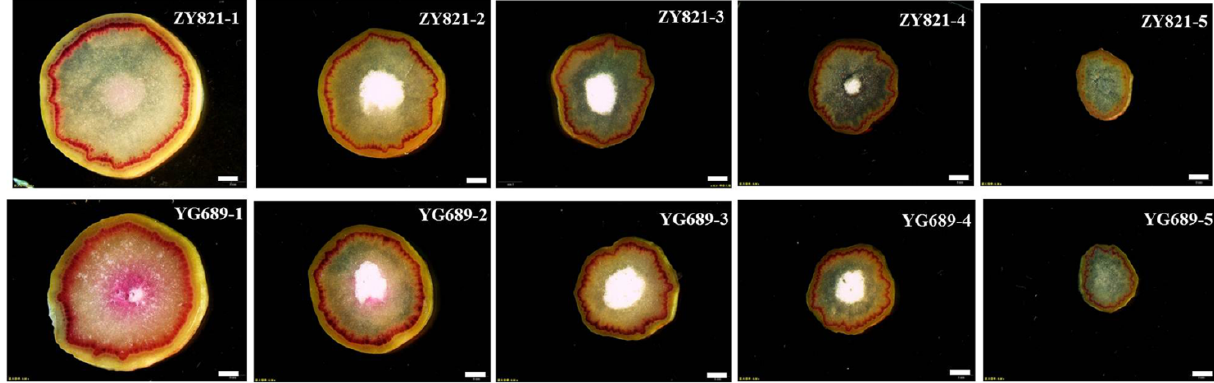
Figure 2. Transverse stem sections of ZY821 and YG689 at initial flowering stage. Stained red characteristics represent the distribution of lignin. The plant is divided into five parts from the base to the top, in turn, and labeled 1, 2, 3, 4, and 5. Bar = 2 mm.